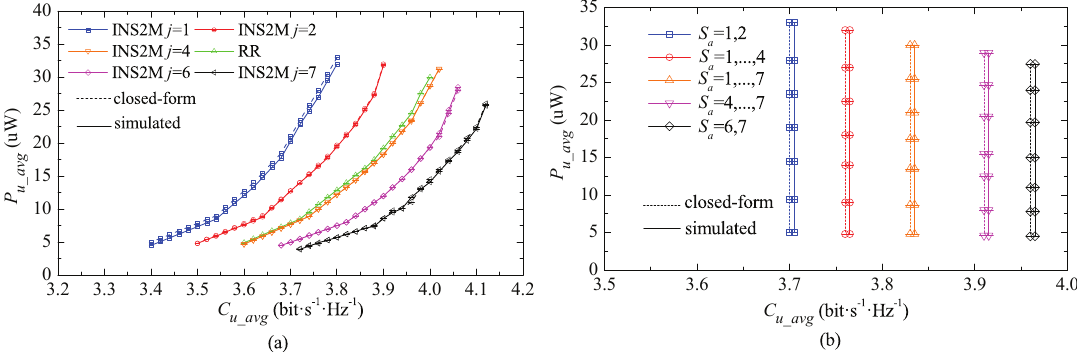
Figure 5. The energy efficiency of INS2M, RR and IETSM in the Ricean fading channel with N = 7 and K = 6. ( a ) INS2M; ( b )